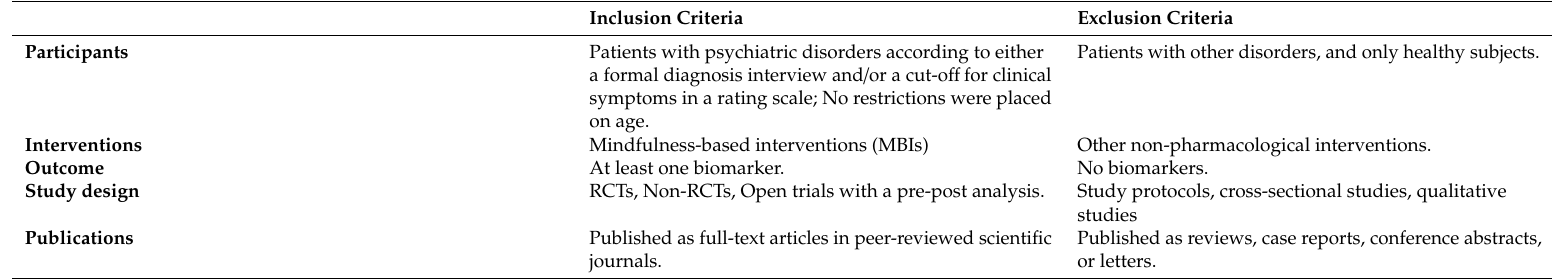
Table 1. Study eligibility